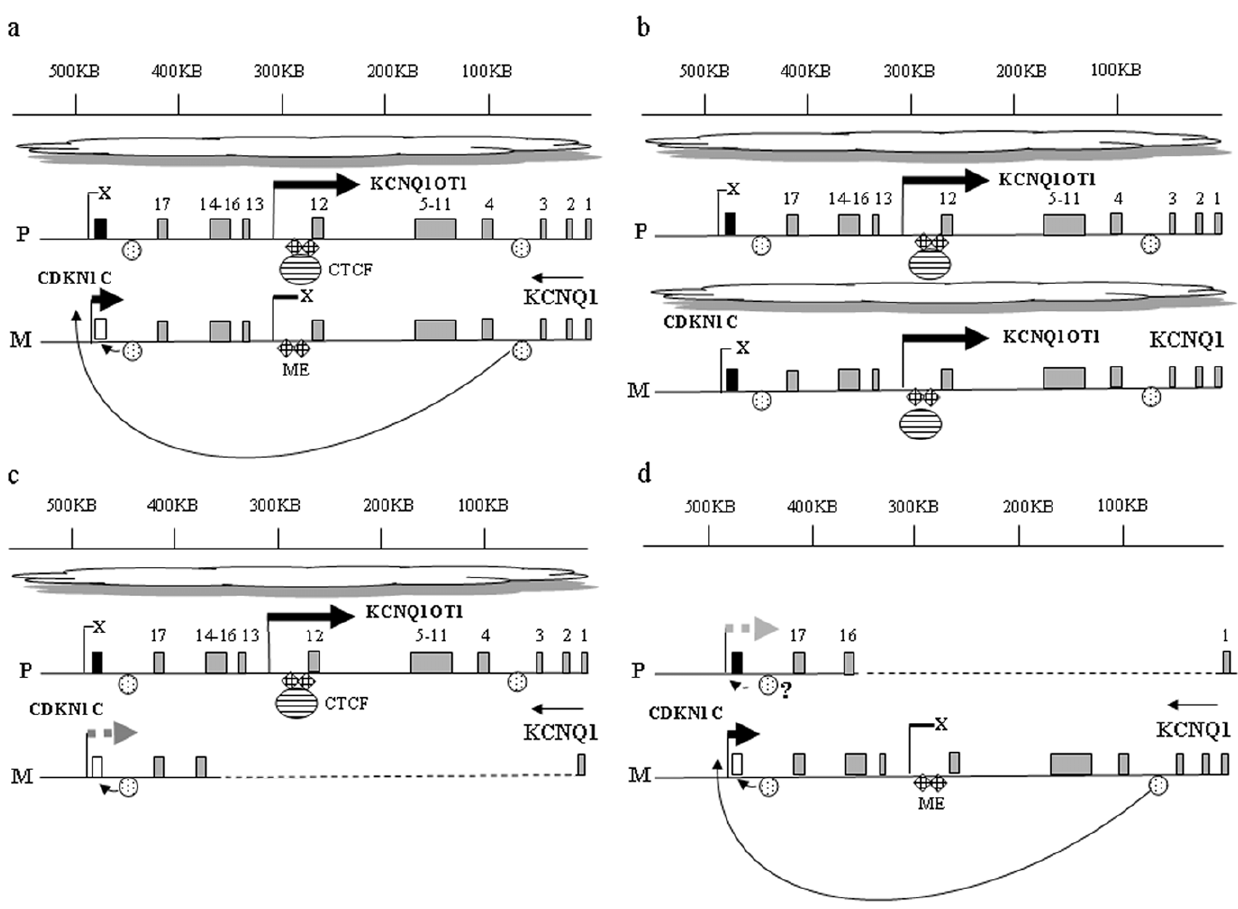
Figure 4. Model of normal and disrupted imprinting regulation at the CDKN1C locus. Genomic distances were calculated from NCBI reference sequence NG_008935.1. (a) CDKN1C imprinting is maintained on the paternal chromosome by KCNQ1OT1 transcription leading to bidirectional gene silencing (indicated by spreading cloud) and formation of a chromatin insulator within the KVDMR (CTCF binding) that prevents a dominant distant CDKN1C enhancer from activating paternal CDKN1C expression. On the maternal chromosome, methylation within the KVDMR prevents chromatin insulator formation, KCNQ1OT1 is silent, and the distance enhancer can activate maternal CDKN1C expression. (b). In BWS cases with LOM within KvDMR, bidirectional gene silencing on both paternal and maternal chromosomes occurs, chromatin insulators exist on the maternal and paternal chromosomes and distant CDKN1C enhancers can no longer activate maternal CDKN1C expression. Mosaicism for the LOM epimutation allows some CDKN1C expression to occur. (c). Maternal deletion of 330 kb within the KCNQ1 locus removes the KvDMR, and the distant enhancer element, thereby reducing the maternal CDKN1C expression that is normally activated by distant enhancers. Enhancers located close to CDKN1C, not affected by deletion, may still be active and allow CDKN1C expression in some tissues. (d). Paternal deletion of 330 kb has a minimal effect on CDKN1C expression because even though the KvDMR is deleted on the paternal chromosome, the distant enhancer for CDKN1C is also deleted, neutralizing any potential for activation of paternal CDKN1C. Proximal CDKN1C enhancers unaffected by deletion may be active in some tissues. Maternal CDKN1C expression is unaffected.